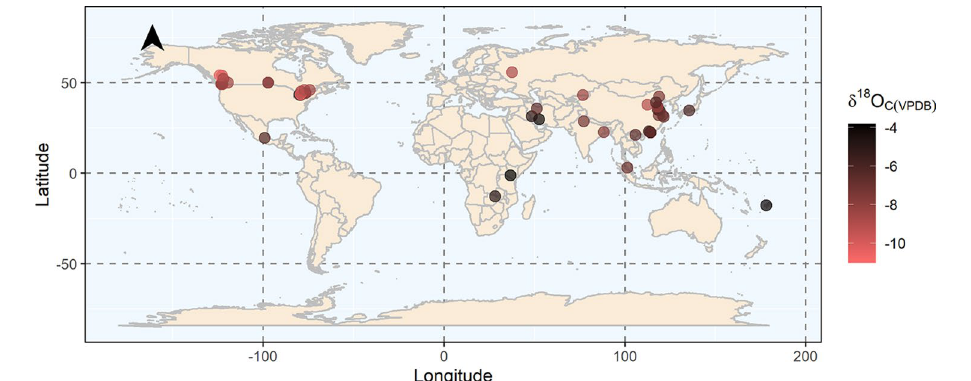
Figure 2. Locations of residence during tissue formation with the corresponding δ 18 O C(VPDB) values for all collected samples. This map was generated using R version 4.0.3 (https:// www.R- proje ct. org/) 58